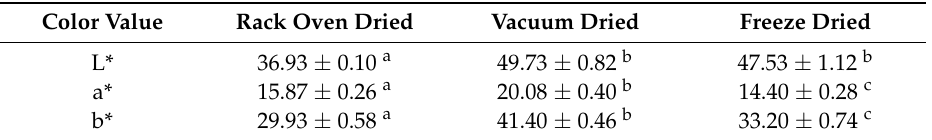
Table 2. Color parameters of rack oven dried, vacuum dried and freeze dried mealworm larvae. Color Value Rack Oven